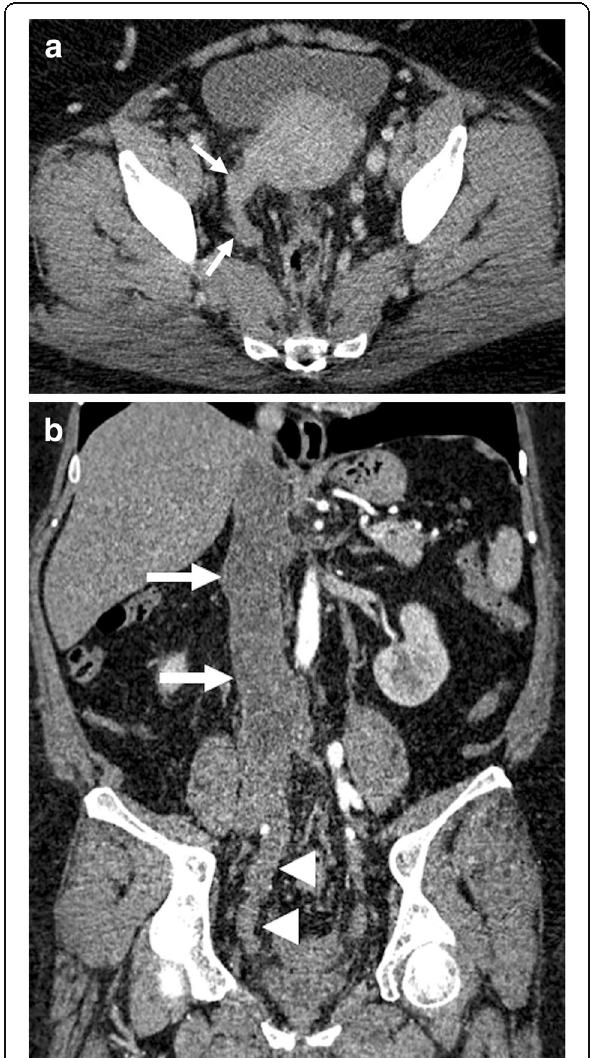
Fig. 17 A 60-year-old female with no past medical history presented with lower extremity edema and postmenopausal